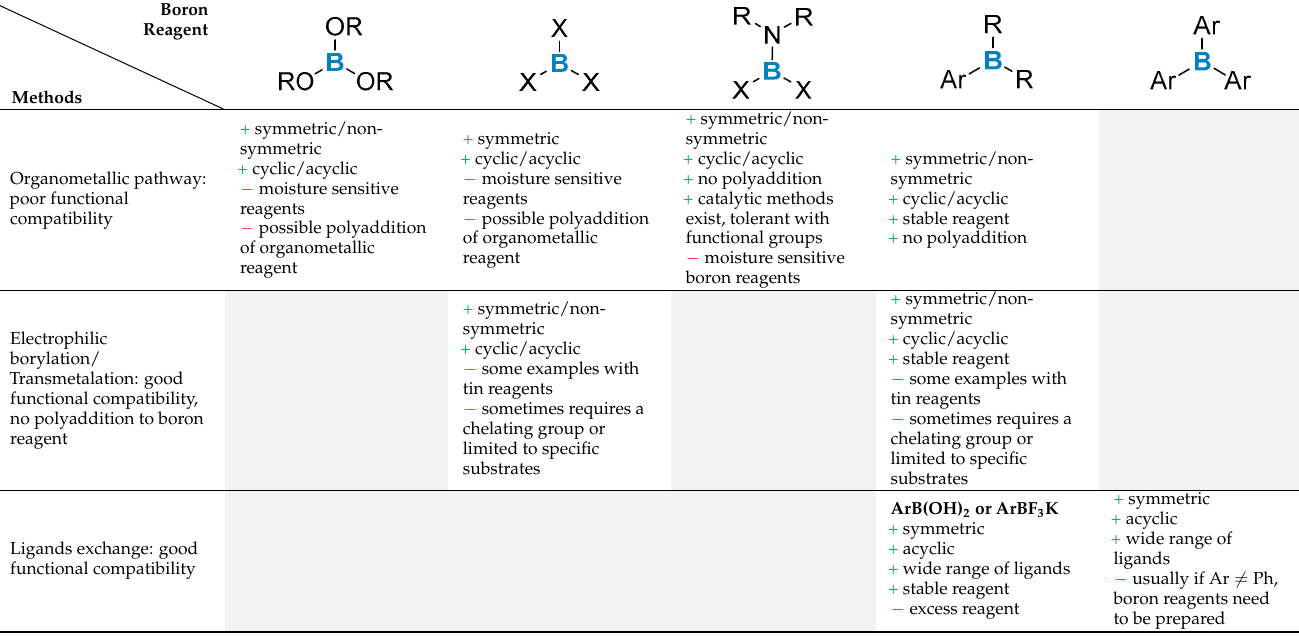
Table 1. Advantages and limitations of the main boron reagents and methods.